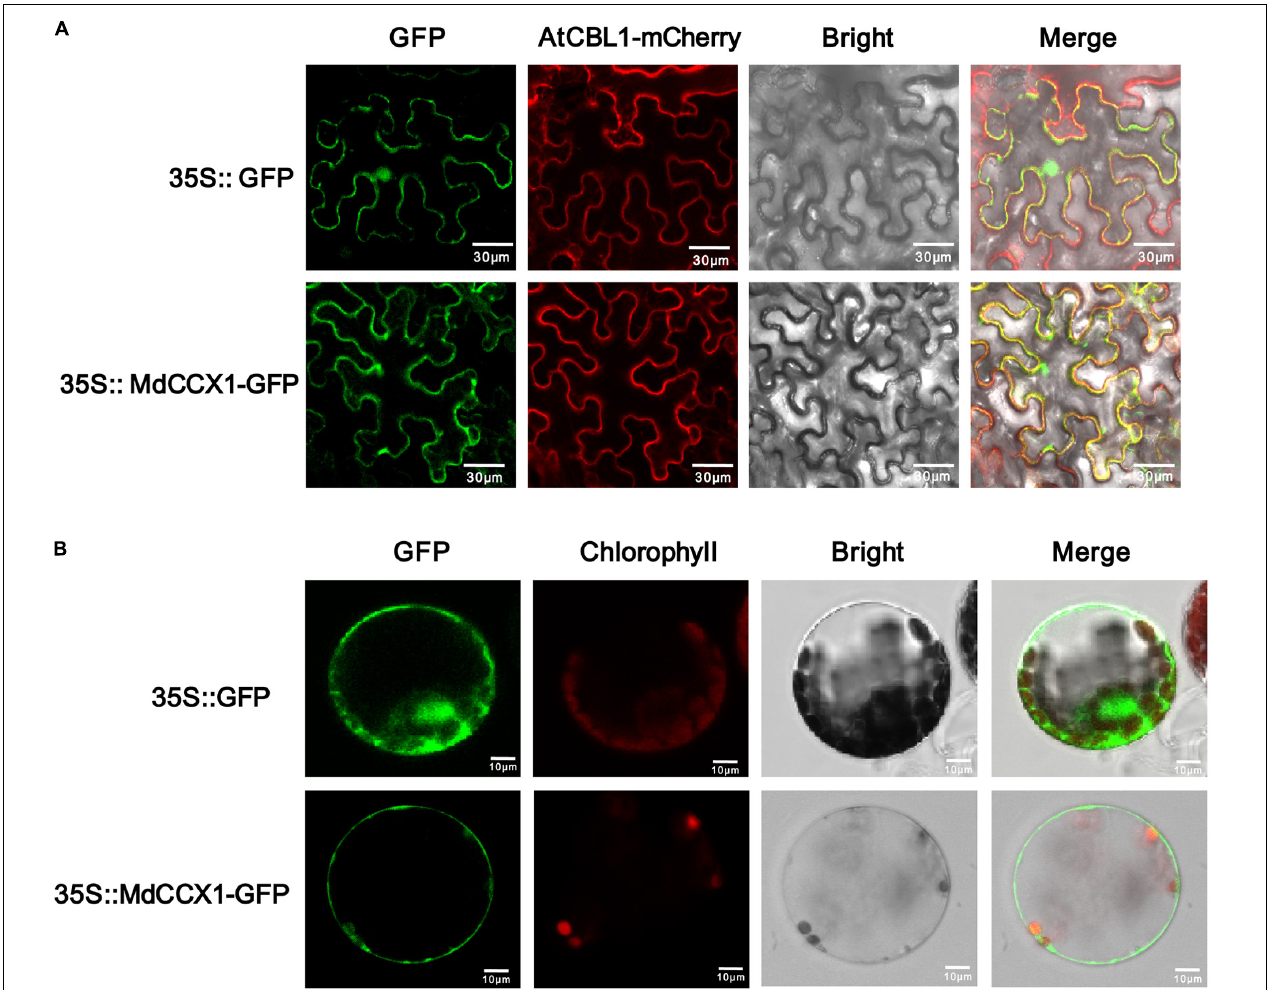
FIGURE 2 | Subcellular localization of the MdCCX1 protein. (A) Fluorescence of the MdCCX1-GFP fusion protein in tobacco epidermal cells. The AtCBL1-mCherry fusion protein served as a plasma membrane-localized marker. (B) Fluorescence of the MdCCX1-GFP fusion protein in Arabidopsis protoplasts. The empty pCambia2300-GFP vector was used to express the GFP protein as a control. Fluorescence, bright field, and merged images of representative cells are shown. Scale bars, 30 µ m in tobacco epidermal cells; 10 µ m in Arabidopsis